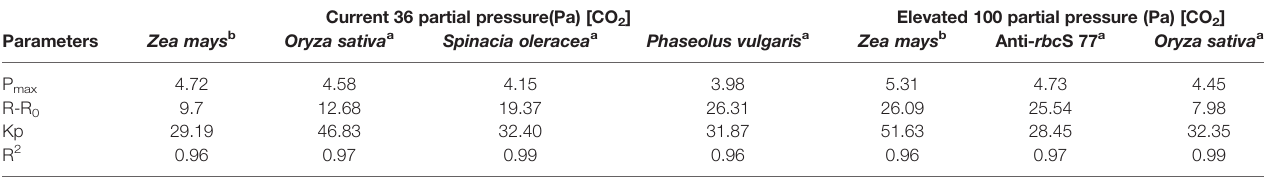
TABLE 2 | Variations in the logarithmic-photosynthesis rates (ln P max ) of C 3 and C 4 species, at 36 and 100 partial pressure, under limited leaf N content (R – R 0